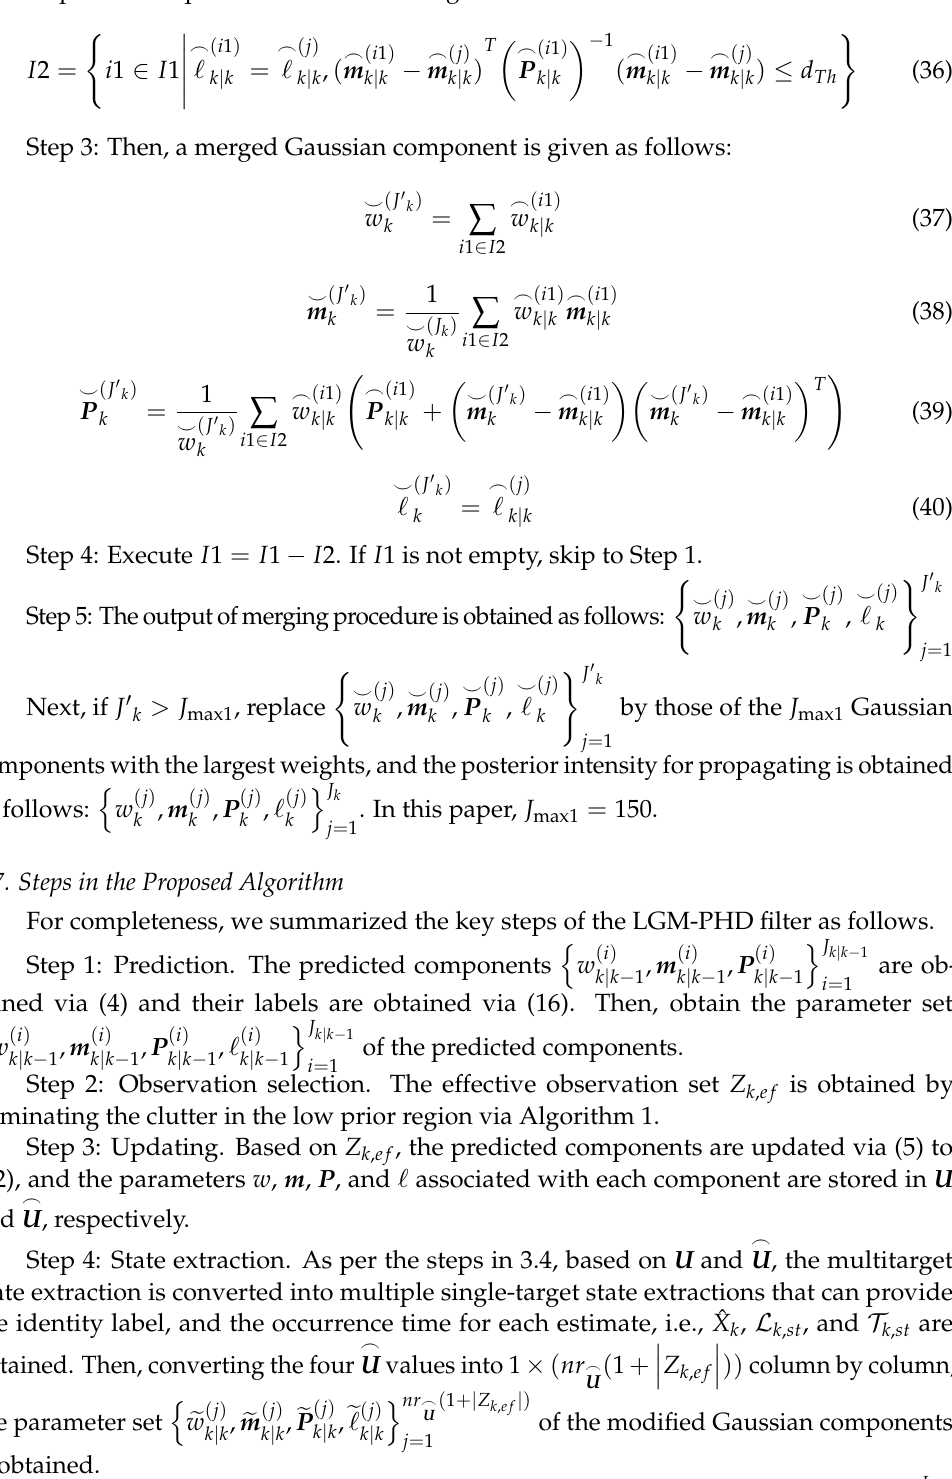
of the modified Gaussian